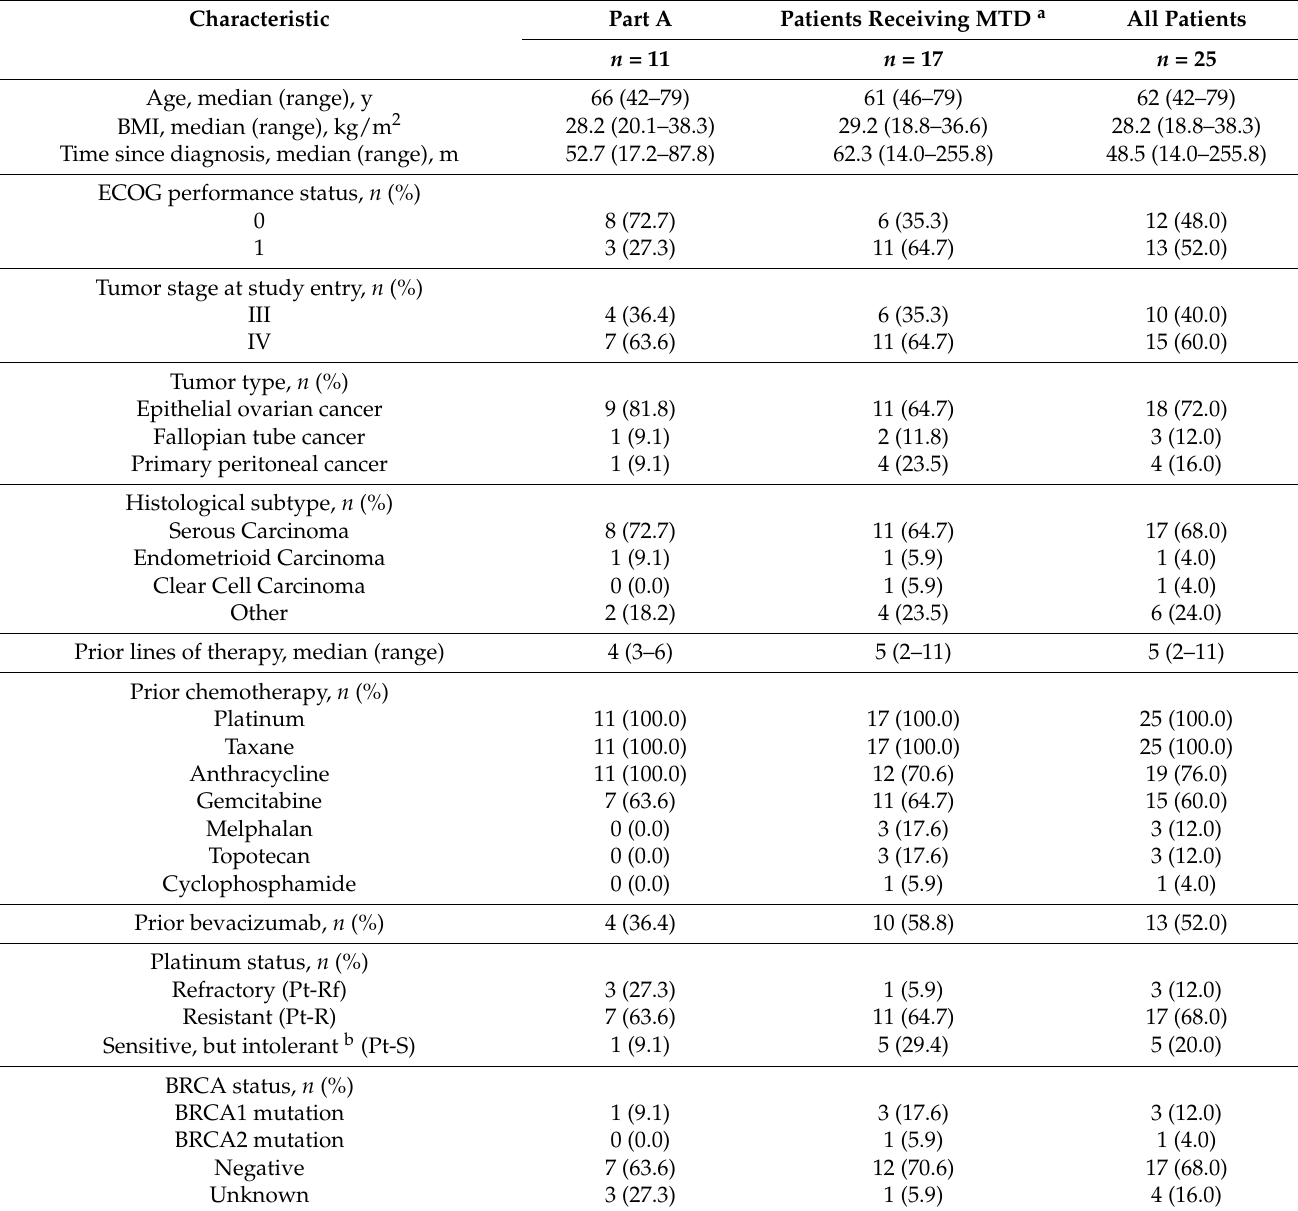
Table 1. Patient characteristics at